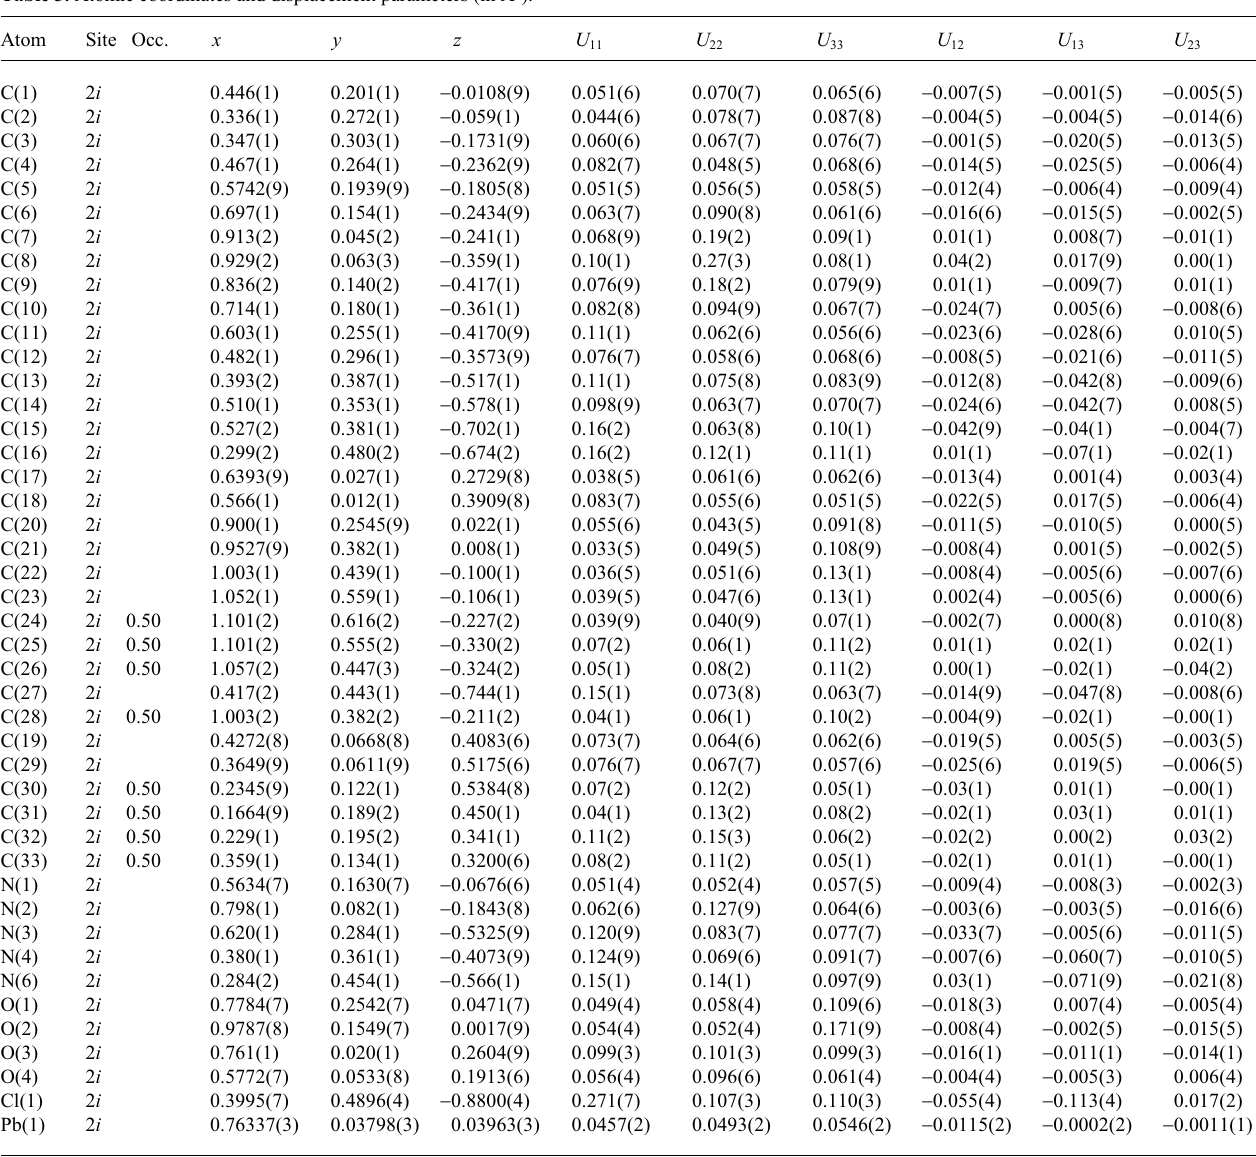
Table 3. Atomic coordinates and displacement parameters (in Å 2